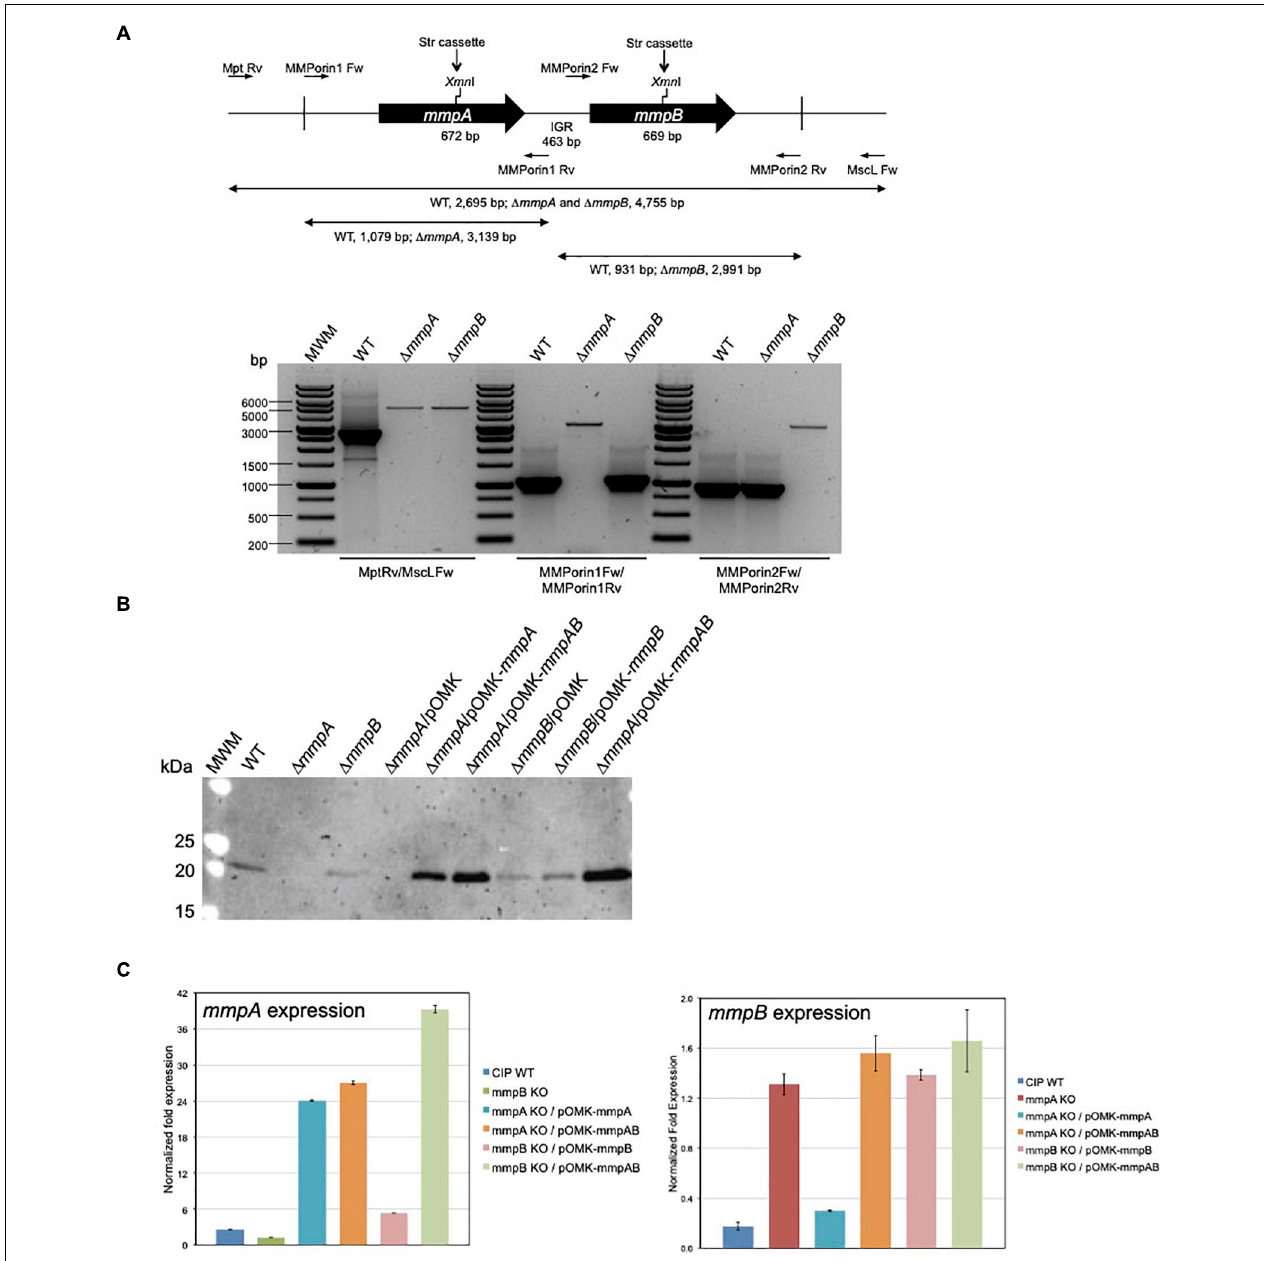
FIGURE 3 | Gene replacement at the mmpA and mmpB porin loci of Mmas . (A) Porin gene cluster of Mmas CIP108297. The positions of the primers used to generate the allelic exchange substrates and analyze the candidate mutants are indicated along with the expected sizes of the PCR fragments. Candidate mmpA and mmpB mutants were analyzed by PCR using different sets of primers, including Mpt-Rv/MscL-Fw located outside the allelic exchange substrates, MMPorin1 Fw/MMPorin1 Rv, and MMPorin2 Fw/MMPorin2 Rv (see Supplementary Table 1 ). MWM, molecular weight marker; IGR, intergenic region. (B) Immunoblot analysis of porin production in the WT, mutant and complemented mutant strains. Strains were grown in 7H9-OADC-Tween 80 broth at 30 ◦ C to mid-log phase (OD600 = 1) and porins were selectively extracted from whole cells at 100 ◦ C using 0.5% n -octylpolyoxyethylene as a detergent as described (Heinz et al., 2003). Protein samples prepared from the same amount of cells for each strain were denatured by boiling in 80% DMSO followed by acetone precipitation (Heinz et al., 2003). Denatured proteins were loaded volume to volume, separated by SDS-PAGE, blotted onto a nitrocellulose membrane, and porins were detected using rabbit antiserum to purified MspA (Stahl et al., 2001). Immune complexes were detected by chemiluminescence (Pierce, ELC) and semi-quantified using the Image Lab software (Biorad). The expected size of the mature MmpA and MmpB porins is 19.65 kDa. (C) mmpA and mmpB mRNA levels in the WT, mutant and pOMK complemented mutant strains. The target cDNA was normalized internally to the sigA cDNA in the same sample. Ratios of mmpA / sigA or mmpB / sigA mRNA are means ± standard deviations ( n = 3 qRT-PCR reactions). RNA extractions and qRT-PCR experiments were performed twice using independent culture batches and the results of one representative experiment are